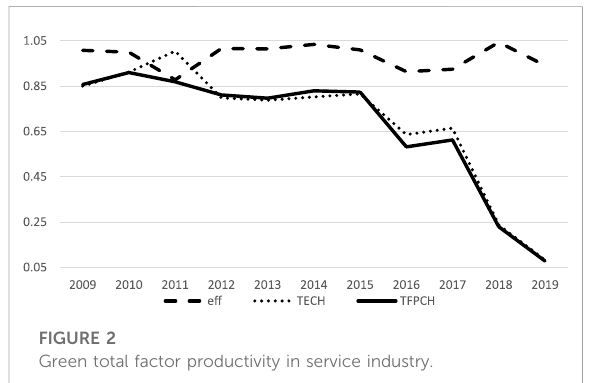
FIGURE 3 North south difference in the development of service